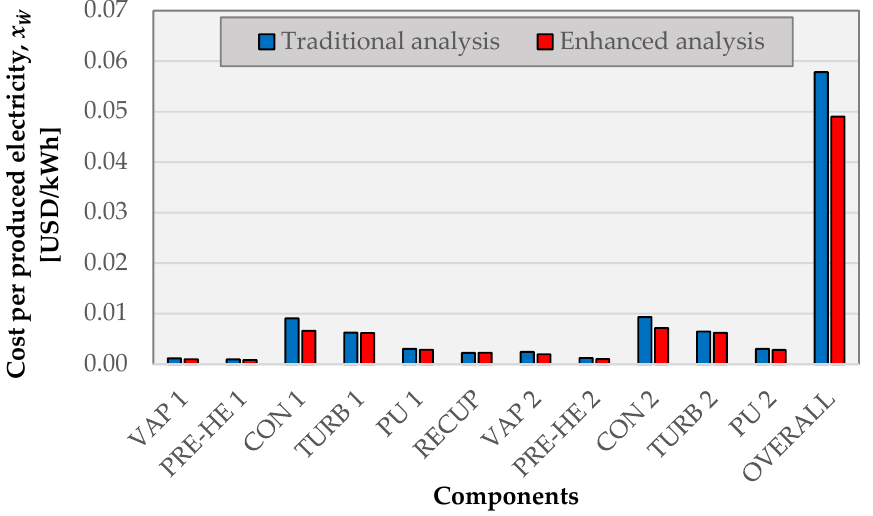
Figure 7. Change in cost per produced electricity for the components for both analyses.